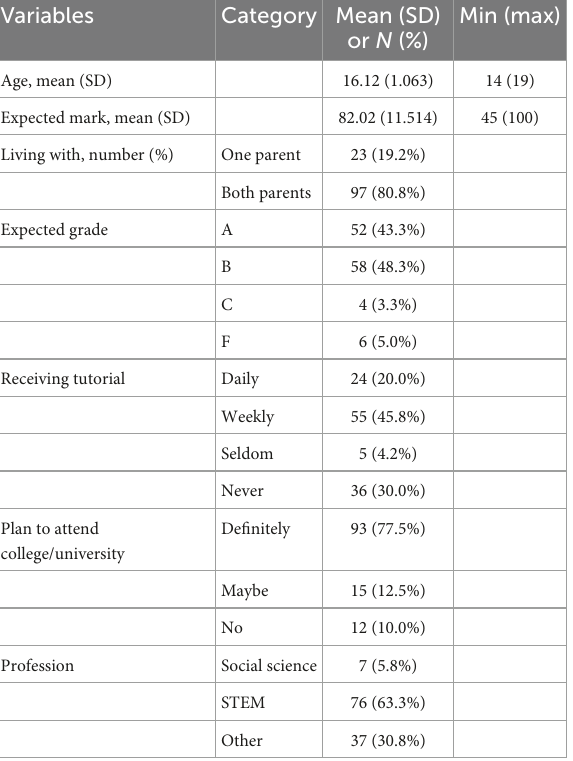
TABLE 1 Demographic characteristics of the